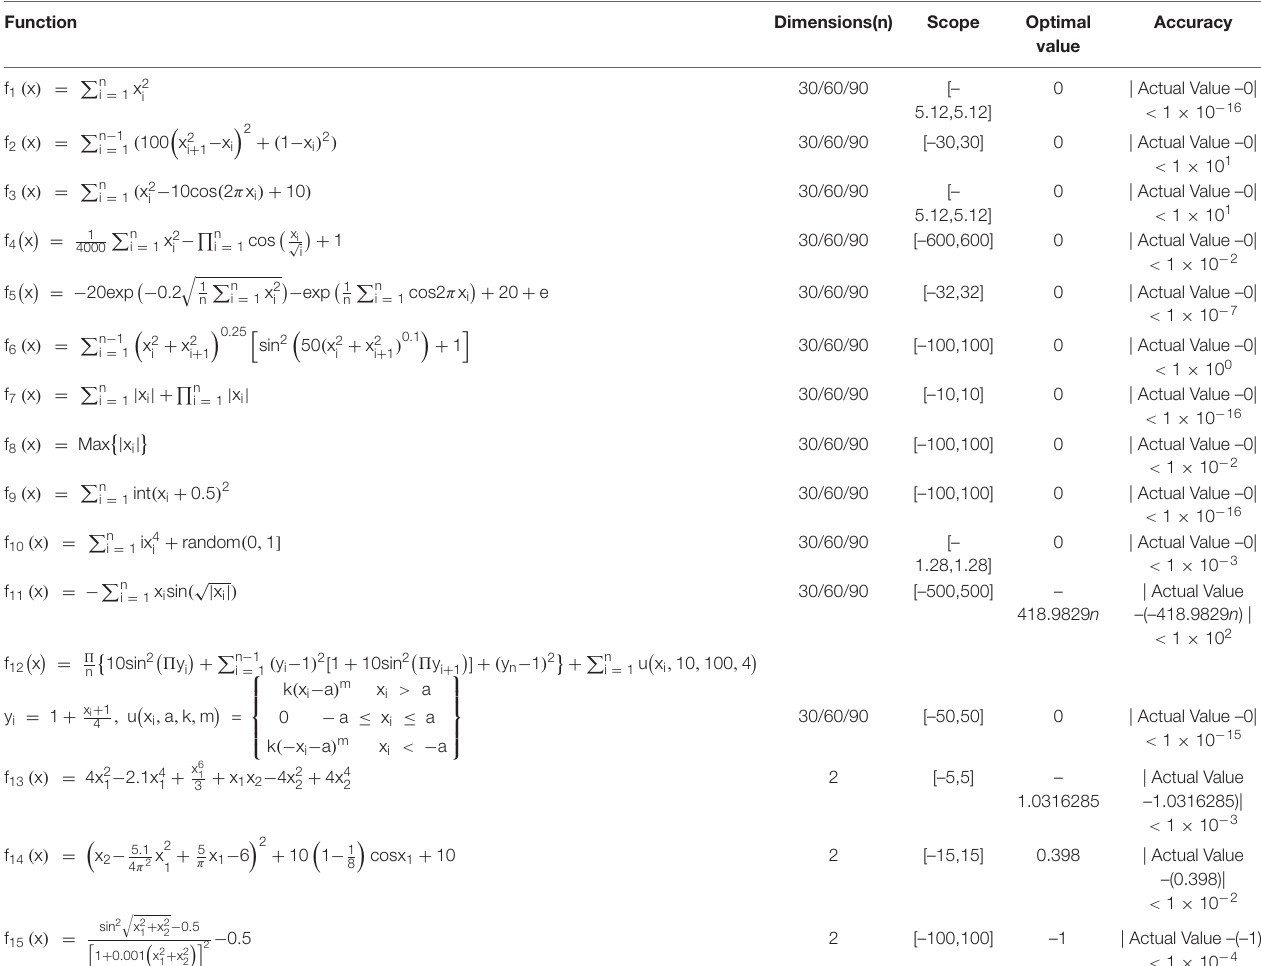
TABLE 1 | Parameters of the benchmark function.